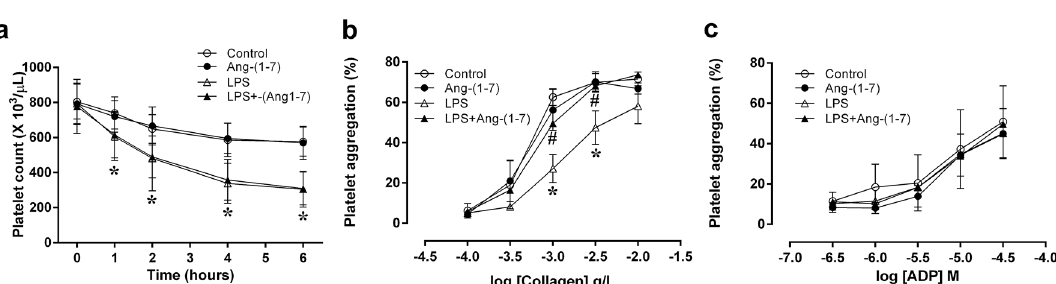
Figure 3. Effects of angiotensin-(1–7) on platelet counts and aggregation. We assessed the changes in platelet counts ( a ) during the experimental period in rats infused with 0.9% NaCl (control, n = 6), angiotensin (Ang)-(1– 7) (1 mg/kg for 3 h, n = 6), E. coli lipopolysaccharide (LPS, 10 mg/kg for 15 min, n = 12), or LPS plus Ang-(1–7) (1 mg/kg for 3 h at 0.5 h after LPS, n = 12). Platelet aggregation was measured using various concentrations of collagen ( b ) and adenosine diphosphate (ADP) ( c ) to activate platelets from control (n = 4), Ang-(1–7) (n = 4), LPS (n = 9), or LPS + Ang-(1–7) (n = 9) rats at the end of the experiment (at 6 h). The data are shown as the mean ± standard error of the mean. *, p < 0.05 for LPS vs. control. # , p < 0.05 for LPS + Ang-(1–7) vs.